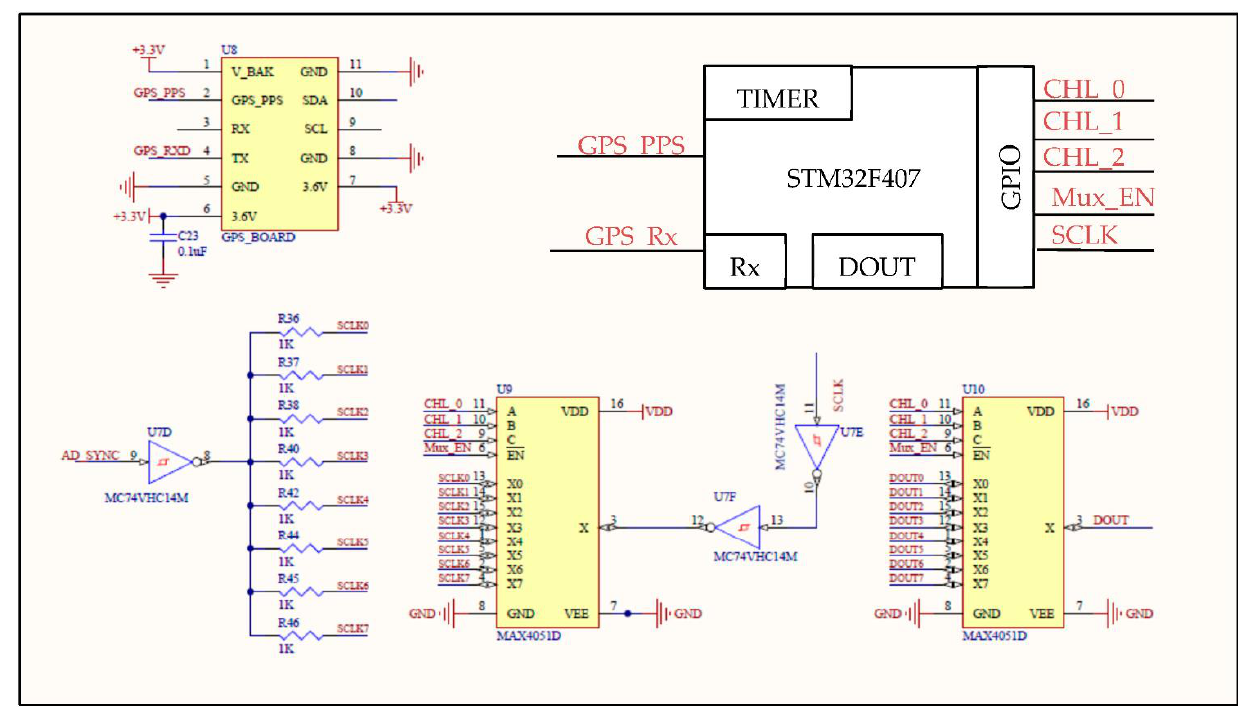
Figure 2. Schematic of the additional hardware peripherals used for the proposed